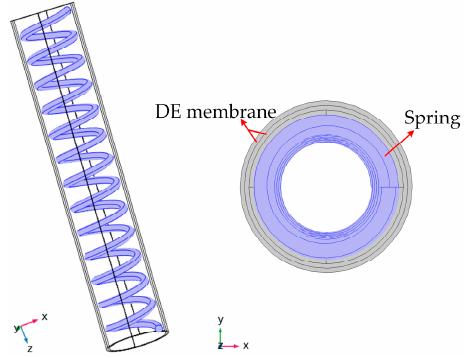
Figure 4. The model of a soft finger. The inner part is a rigid spring with a length of 80 mm and a wire diameter of 0.6 mm. The outer part consists of a two-layer DE membrane.